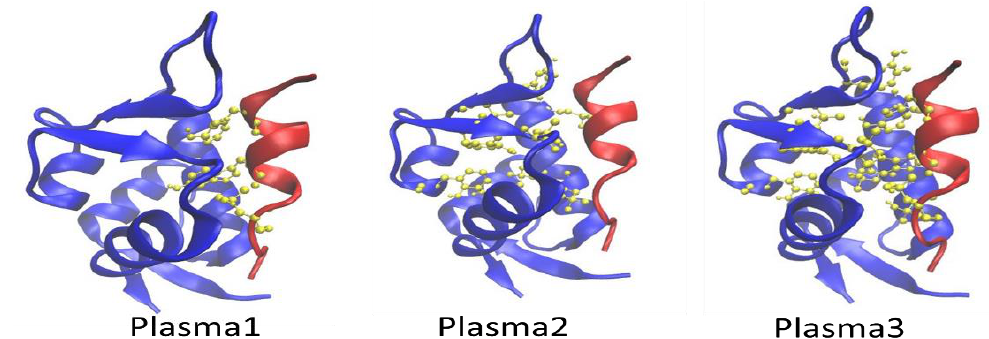
Figure 1. Schematic representation of the different types of oxidized form of Mdm2–p53 proteins plasma1, plasma2, and plasma3. The Mdm2–p53 protein PDB IDs is 1YCR.